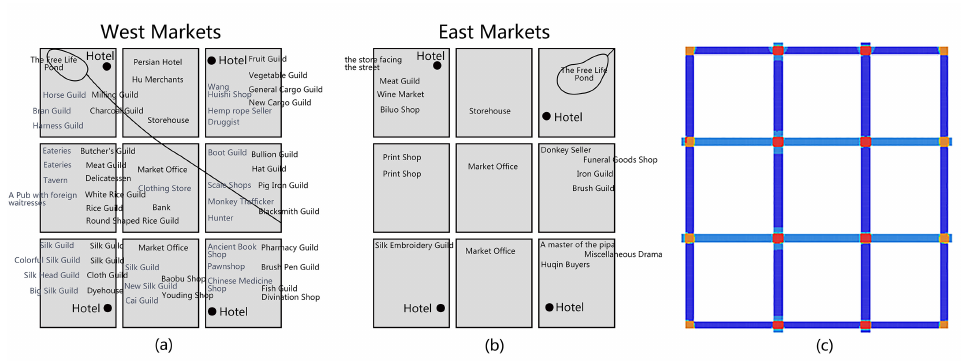
Figure 13. ( a , b ) Internal structure of the East-West Markets in Chang’an of the Tang Dynasty from Shi Nianhai: Historical Atlas of Xi’an, Xi’an Map Publishing House, 1996 and ( c ) visual integration of the east market in Chang’an of the Tang